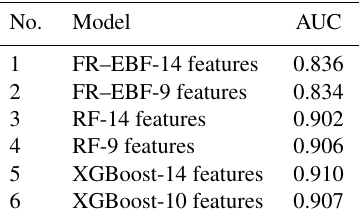
Figure 6. Feature importance of the statistical model (horizontal red line shows 0.3 as the cut-off value). Table 3. Overall table with AUC results for landslide susceptibility of